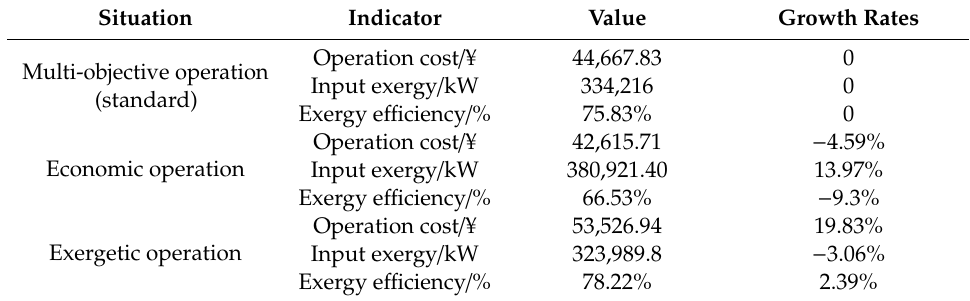
Table 11. Comparison of multi-objective optimization results with single-objective optimization results.